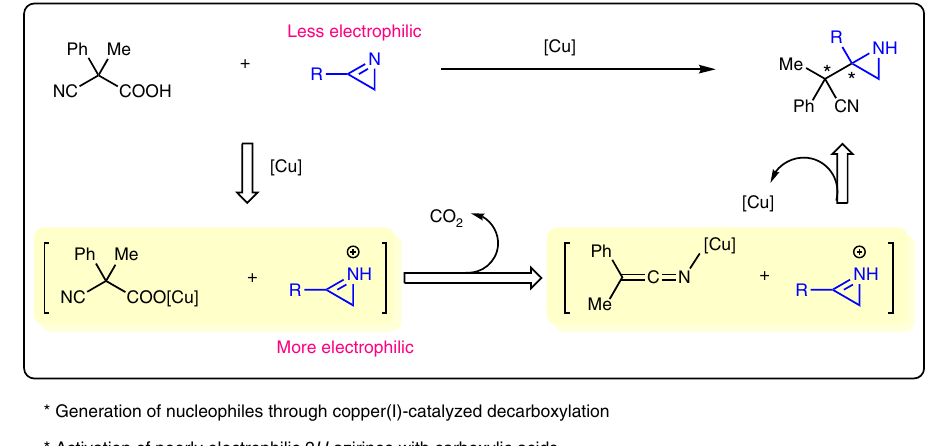
Fig. 1 Initial design. Our working hypothesis for the catalytic asymmetric decarboxylative Mannich reaction of 2 H